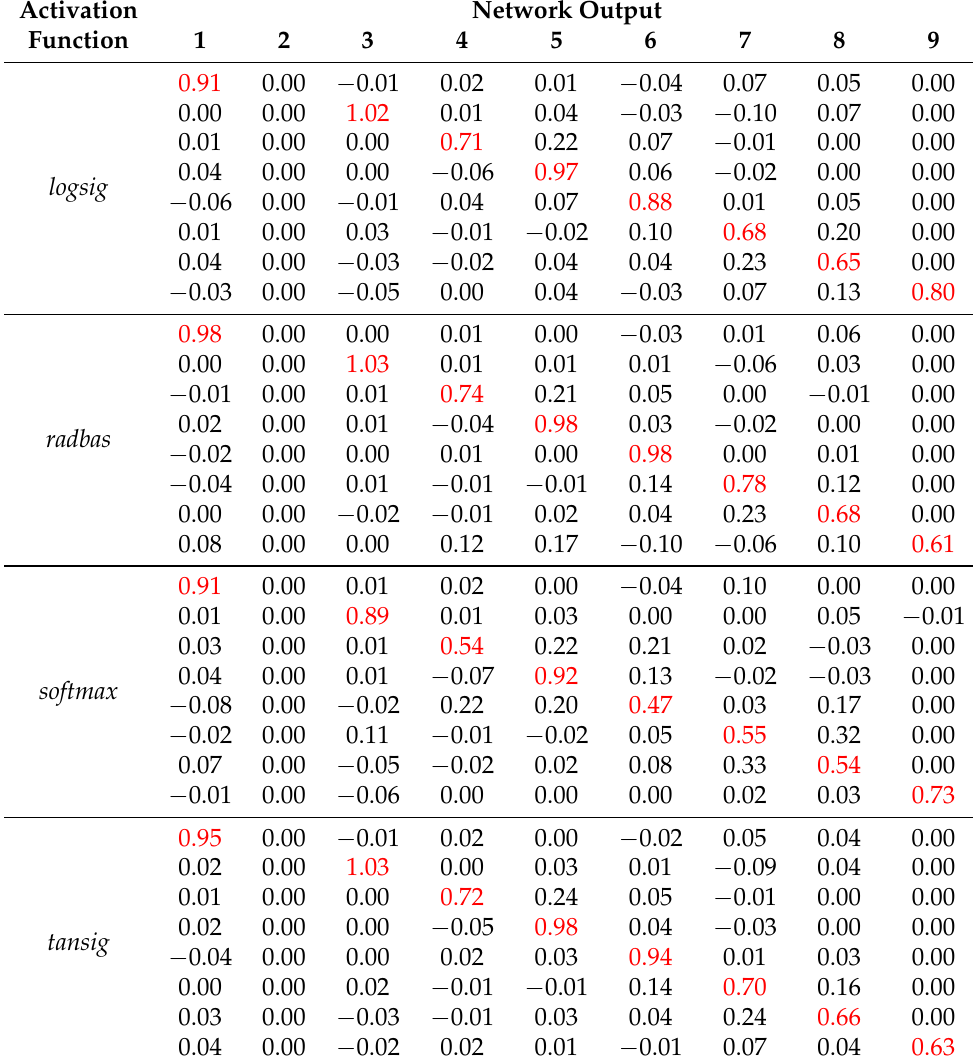
Table 4. Results obtained in network tests (impact of activation function in the hidden